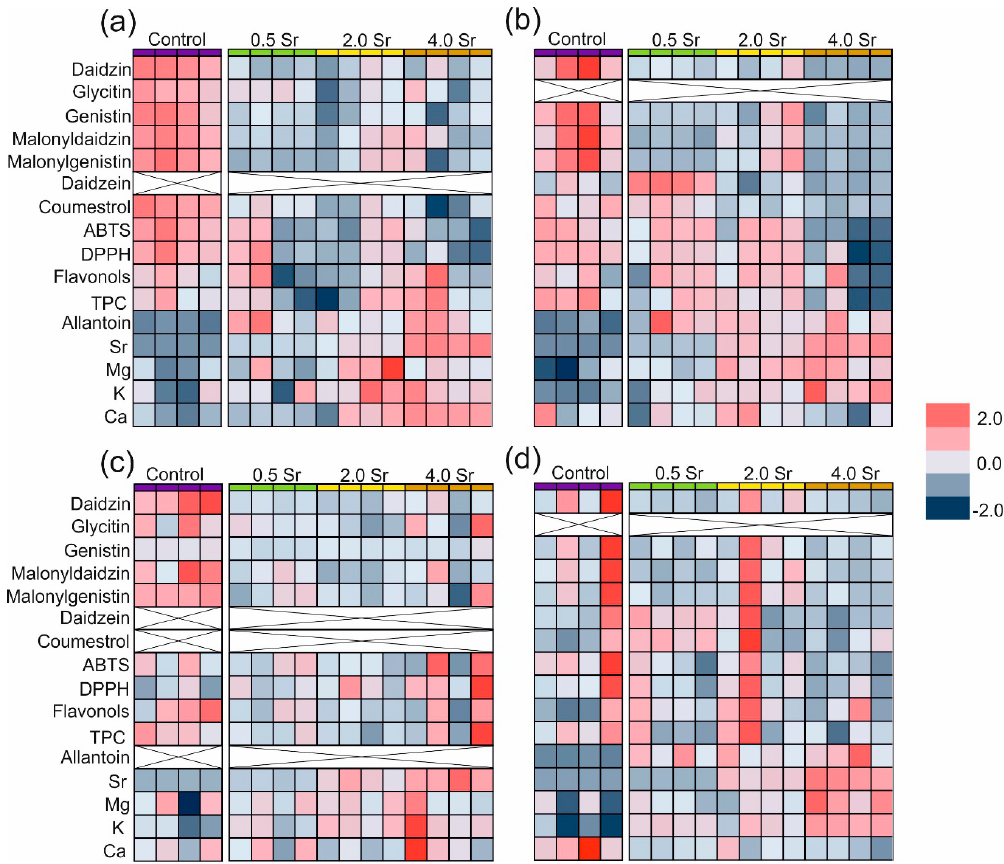
Figure 2. Heat map visualization of changes in the abundance of particular features shown in the rows for individual plant organs treated with different Sr concentrations (column). The colors range from dark blue (low abundance) to deep red (high abundance); ( a ) leaves; ( b ) stems; ( c ) seeds; ( d ) roots.